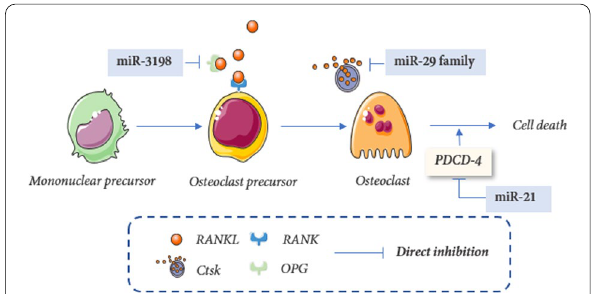
Fig. 5 Mechano-sensitive miRNAs in osteoclastogenesis: The microRNAs are regulated by mechanical force and are implicated in osteoclastogenesis through regulating gene targets in mononuclear precursors, osteoclast precursors, and osteoclast